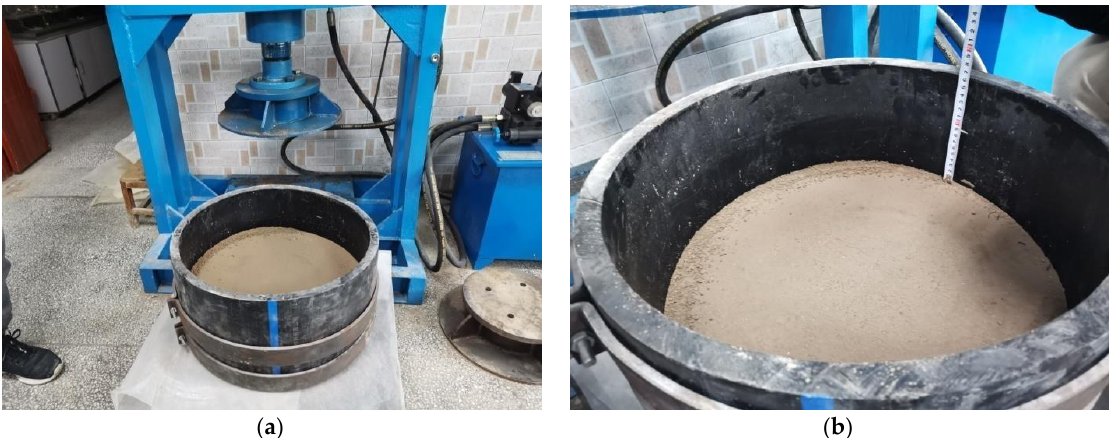
Figure 2. Preparation of soil samples. ( a ) Compaction in layers. ( b ) Compaction thickness control.